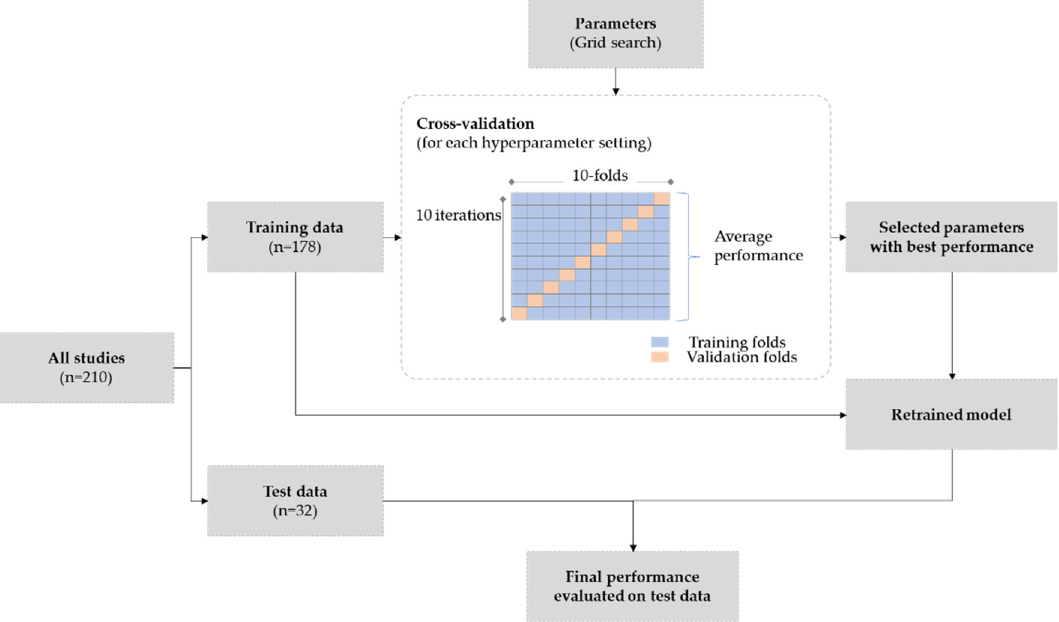
Figure 4. Experimental setup for model training, cross-validation, and final evaluation.